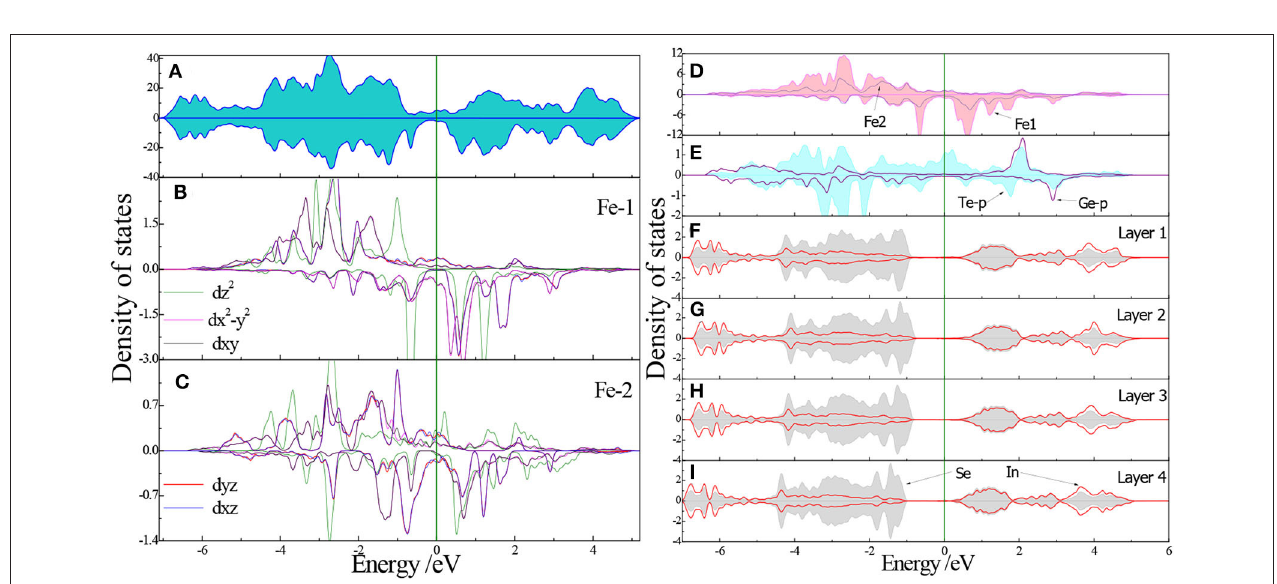
FIGURE 2 | The spin-polarized total/partial DOS (A) and the spin-averaged total DOS (B) of the freestanding Fe 3 GeTe 2 monolayer.